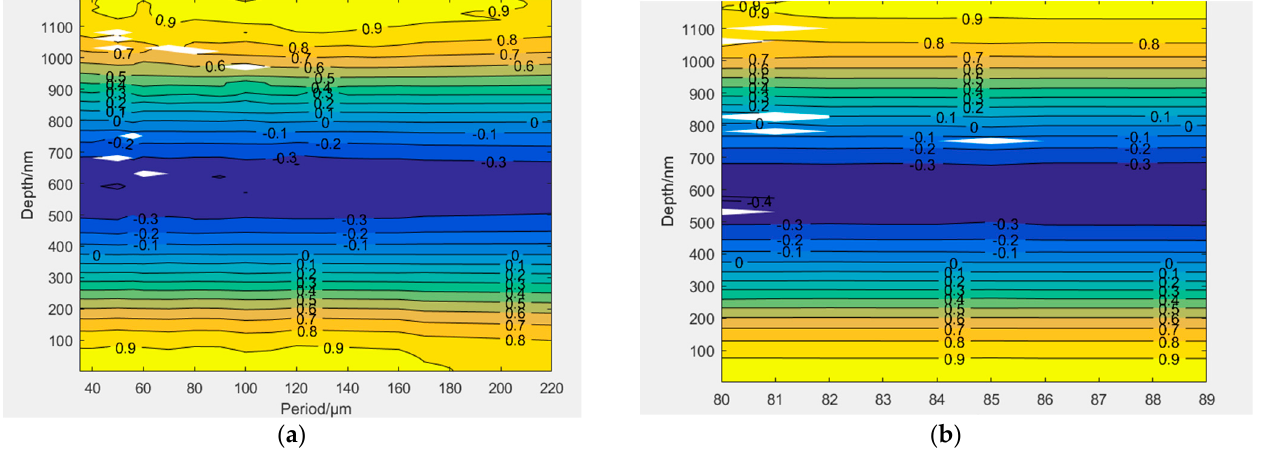
Figure 8. ( a ) Diffraction efficiency difference between level 0 and +1 diffraction versus period ( μ m) and etching depth ( μ m) contours ( b ) Diffraction efficiency difference between level 0 and +1 with respect to the contour of the bottom angle (°) and etching depth ( μ m).